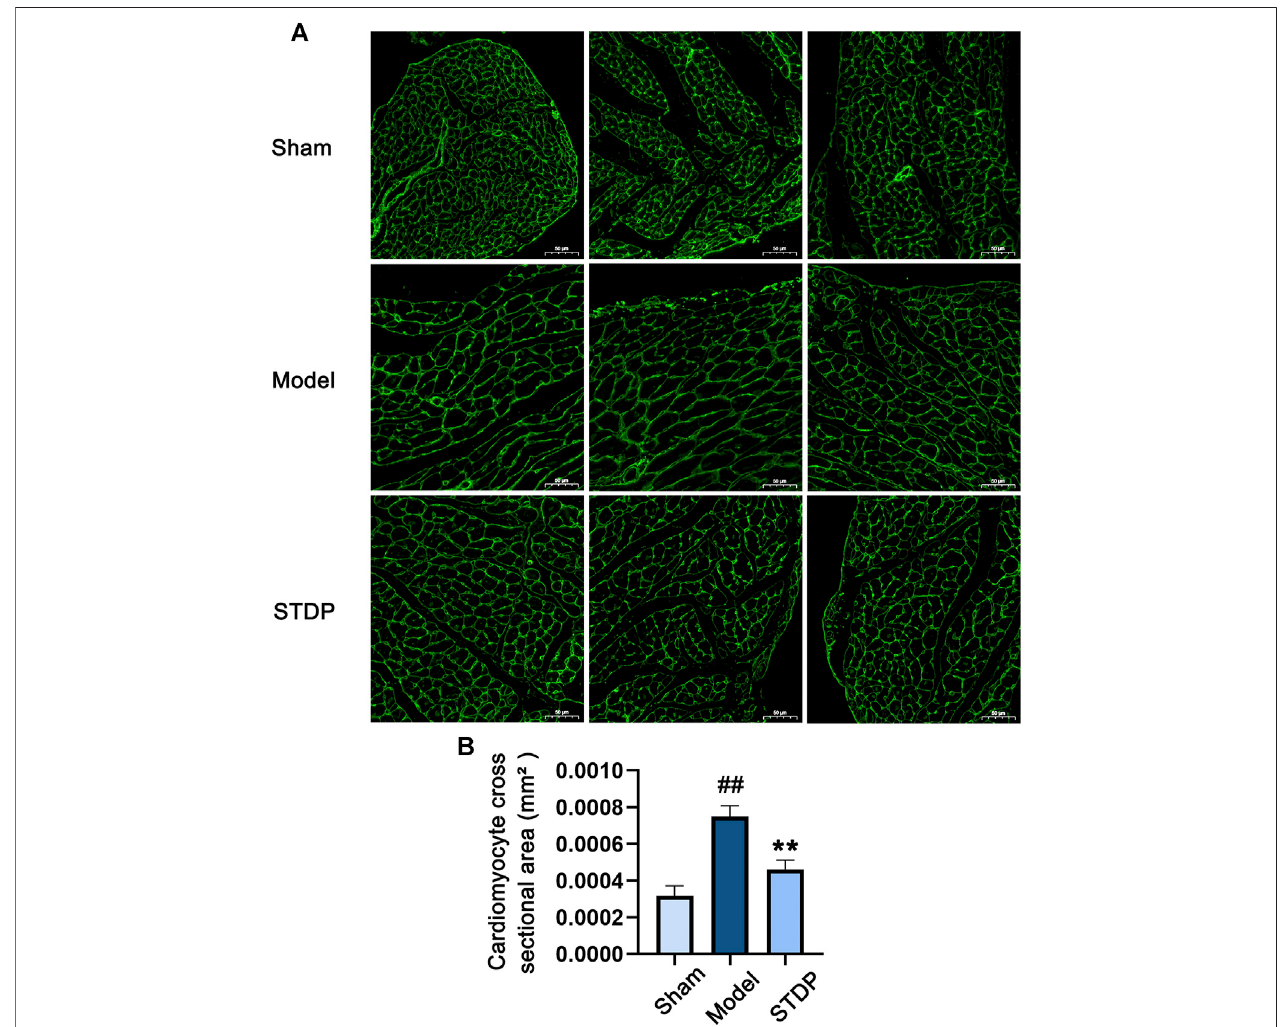
FIGURE 2 | STDP reduces cardiomyocyte hypertrophy in CHF mice. (A) Representative images of mouse left ventricular sections stained with WGA and photographed with fl uorescence microscope (magni fi cation, × 400). Bars (cid:1) 50 μ m. (B) Statistics of cardiomyocyte cross sectional area in mice. ## p < 0.01 versus the Sham group; ** p < 0.01 versus the Model group; n (cid:1)